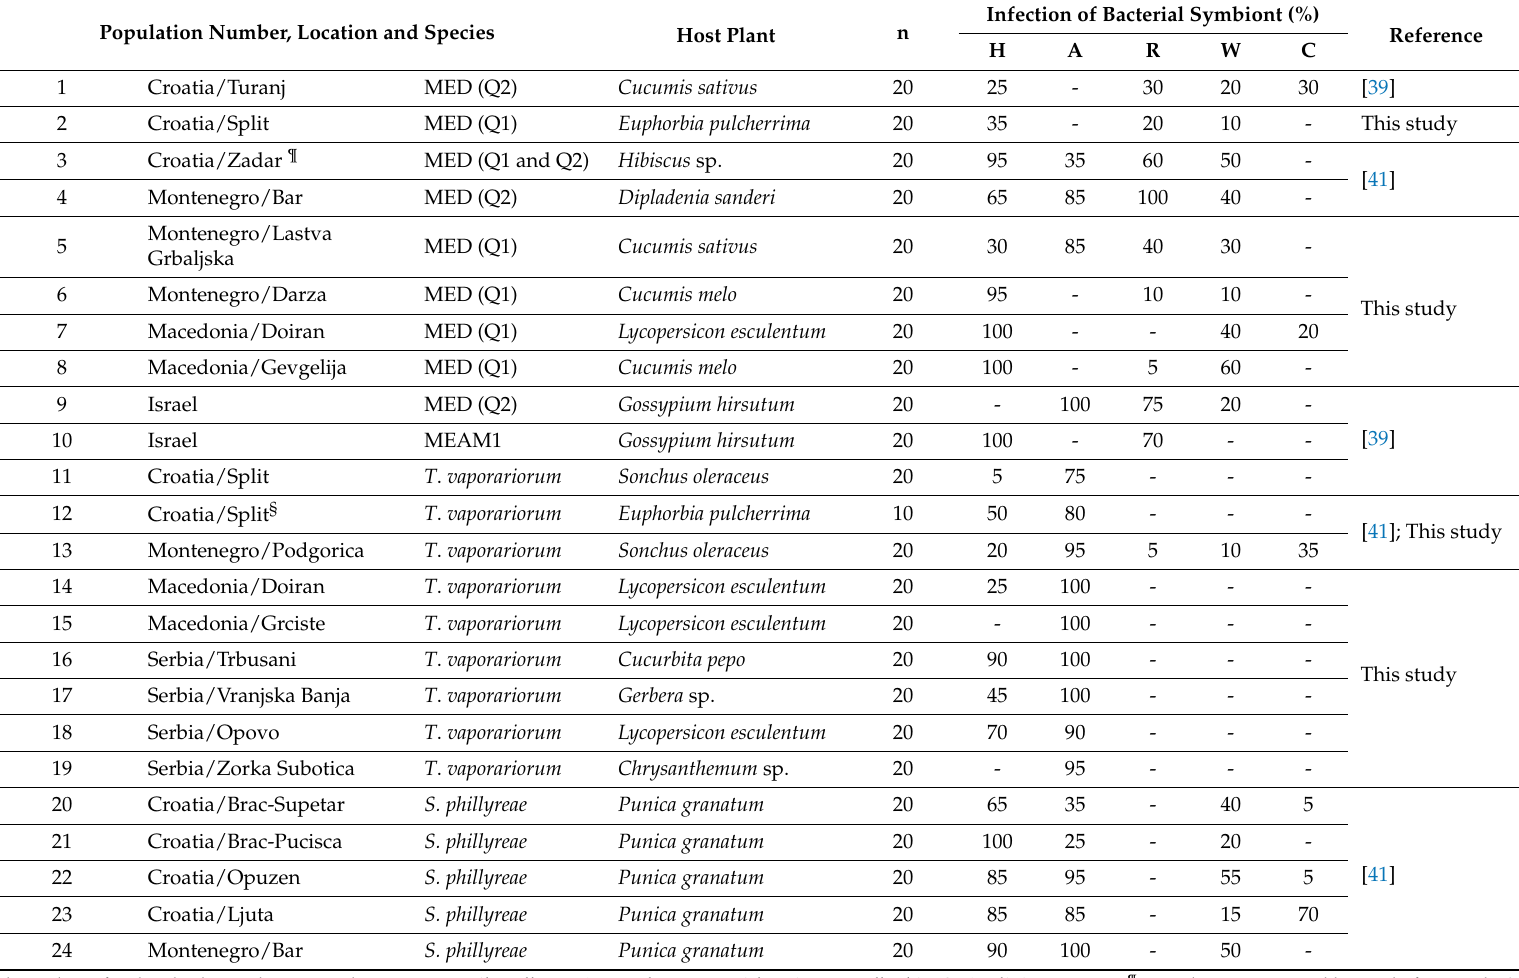
Table 2. Overview of overall infection frequencies of secondary bacterial symbionts in the three whitefly species in Southeast Europe with associated host plants. Infection of Bacterial Symbiont Population Number, Location and Species Host Plant n